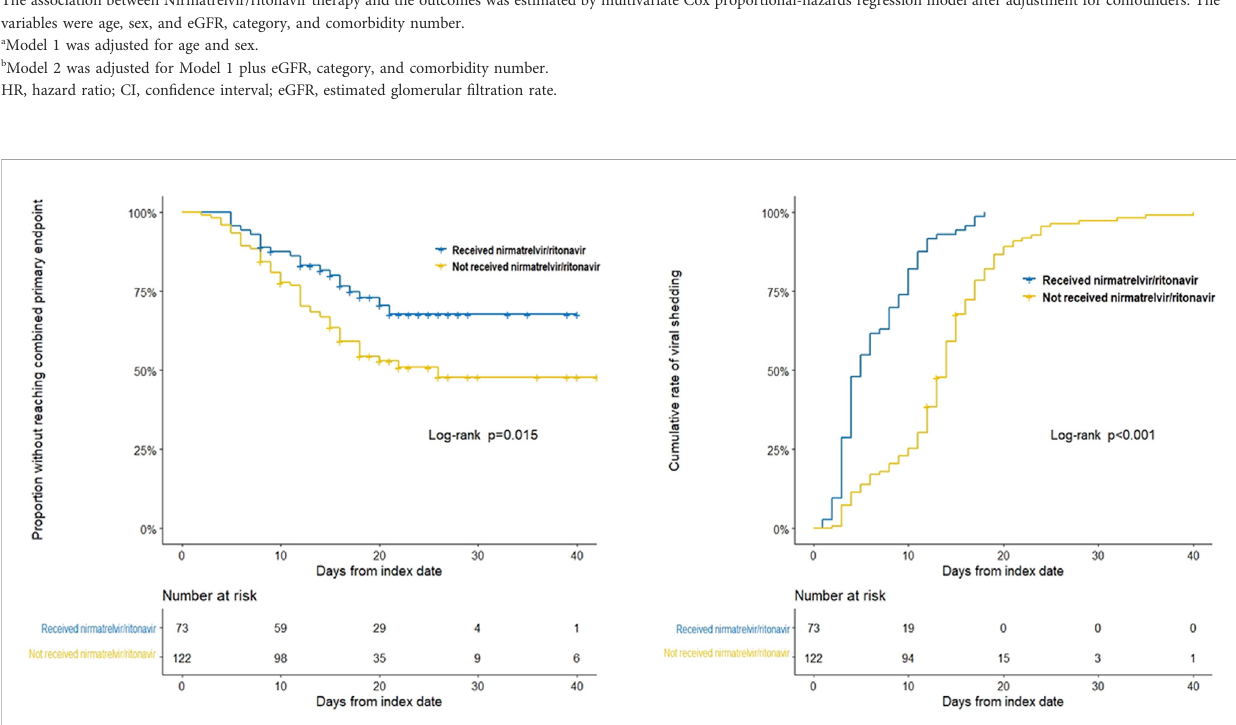
FIGURE 1 Kaplan-Meier analyses of time to the combined primary endpoint and the secondary endpoint in patients with SARS-CoV-2 infection and impaired kidneyfunctionwithorwithoutnirmatrelvir/ritonavirtherapy. TheKaplan-Meierestimate oftheduration fromtherespective indexdateto thecombined primary endpoint and the secondary endpoint. The index date corresponded to the day of nirmatrelvir/ritonavir initiation for patients who received nirmatrelvir/ritonavir therapy, while for patients whodidnot receivenirmatrelvir/ritonavir,indexdate correspondedto theday ofdiagnosis of SARS- CoV-2